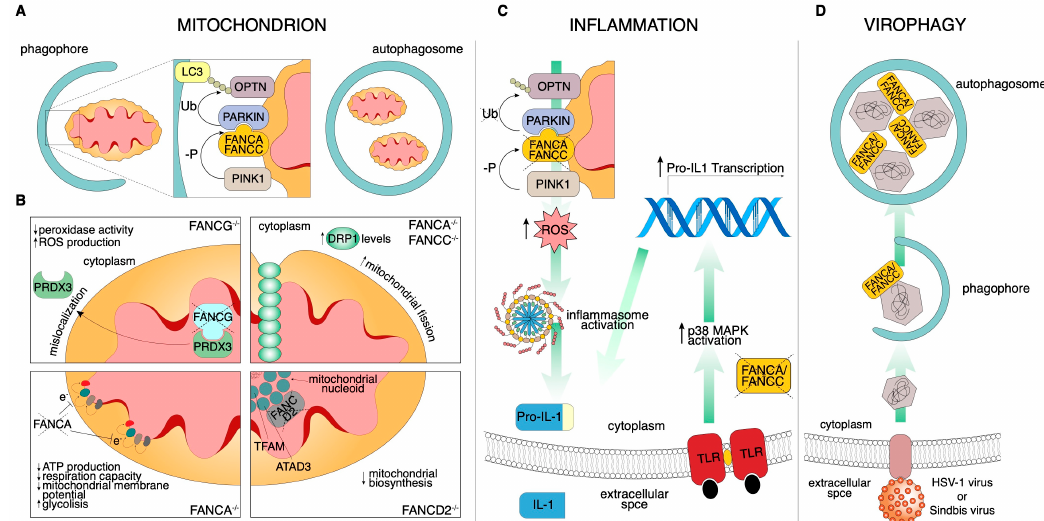
Figure 2. Schematic of the noncanonical FA pathways. ( A ) During mitophagy, damaged mitochondria are selectively engulfed by the phagophore. To properly identify the substrate, the E3 ligase PARKIN ubiquitinates the mitophagy receptor, which acts as an adapter for LC3-mediated autophagosome recognition. In this context, FANCC assists PARKIN localization to the mitochondria. ( B ) FA protein-related mitochondrial functions. (Top left) FANCG-deficient cells display PRDX3 mislocalization. The consequent reduced mitochondrial peroxidase activity increases ROS production. (Top right) FANCA and FANCC downregulated cells show increased DRP1 levels resulting in an increment of mitochondrial fission. (Bottom left) FANCA deficiency impacts negatively on mitochondrial electron transport chain efficiency, reducing ATP production and respiration capacity and altering the mitochondrial membrane potential. This inevitably leads to a shift from aerobic to glycolytic metabolism. (Bottom right) FANCD2 mitochondrial nucleoid complex interaction regulates mitochondrial biosynthesis. ( C ) FANCA and FANCC knockdown increase the pro-inflammatory secretion of IL-1 β in a dual convergent manner. On the left, impaired mitophagy stimulates inflammasome activation through ROS overproduction and, consequently, IL-1 β is secreted. On the right, exogenously stimulated Toll-like receptors activate a signal transduction cascade that culminates with Pro-IL-1 β transcription. ( D ) Both FANCA and FANCC are required for Sindbis and HSV-1 nucleocapsid recognition to control viral infection by virophagy.